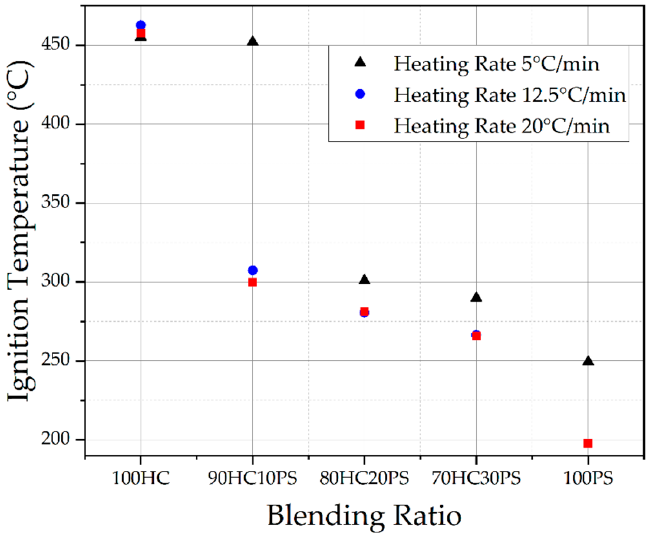
Figure 9. Ignition temperature variation for fuel blends at 5 °C/min and 20 °C/min heating rate under an air atmosphere.